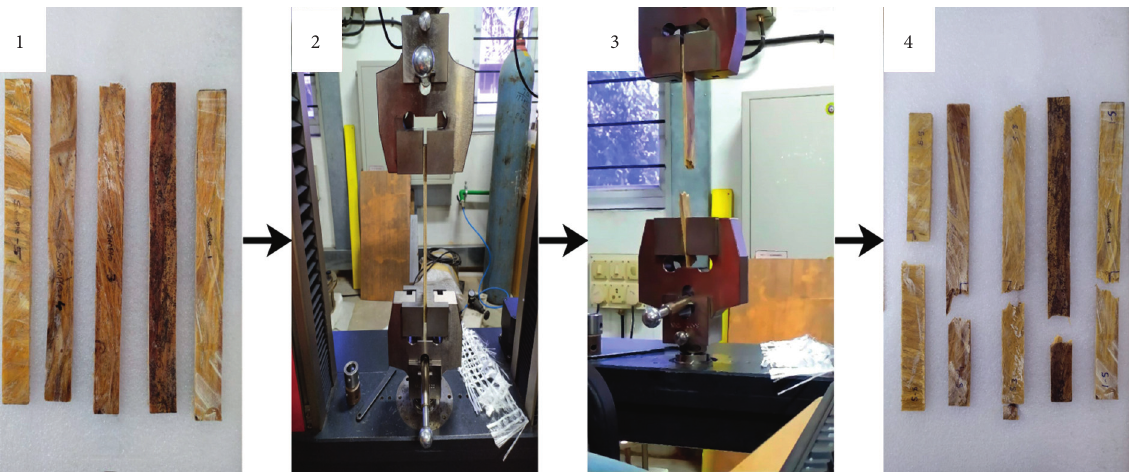
Figure 2: Tensile setup and fractured